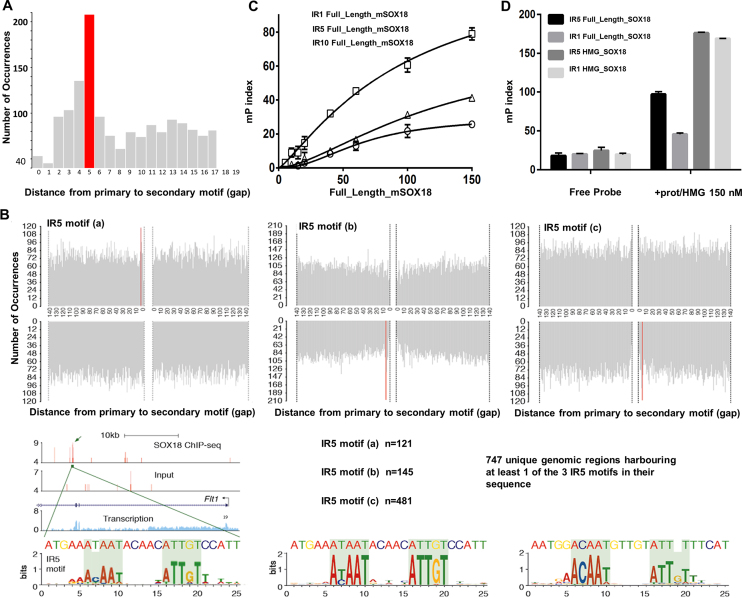
Identification of a consensus sequence for the homodimer of SOX18. (A) Spaced Motif Analysis Tool (SpaMo, MEME suite) analysis on SOX18 ChIP-seq data performed in HUVEC, showing the frequency of a secondary SOX18 motif in proximity of a primary SOX18 ChIP-seq peak at any given distance (1–140 bp). Enrichment for a 5-nucleotide spacer between a SOX inverted motif is shown in red (IR5, P = 0.005). (B) The four quadrants correspond to the strand orientation and upstream/downstream position relative to the ChIP-seq peak. An IR5 was identified for motif combination SOX18-SRY (IR5a), SRY-SRY (IR5b) and SOX18-SOX18 (IR5c). USCS browser track shows representative ChIP-seq peak in the FLT1 gene containing a SOX18 IR5a motif. Position weight matrixes show the inferred motifs based on the peaks containing the IR5a/b/c motifs. (C) Fluorescence polarization analysis of full-length SOX18 binding to FITC-labelled oligonucleotides harboring palindromic SOX18 binding motif identified in (B), separated by a 1 (IR1), 5 (IR5) or 10 (IR10) nucleotide spacer. Higher mP index indicates that SOX18 binds more favorably to IR5. (D) Fluorescence polarization analysis of full-length SOX18 and SOX18 HMG box construct binding to FITC-labelled oligonucleotides harboring palindromic SOX18 binding motif identified in (B), separated by a 5 (IR5) or 1 (IR1) nucleotide spacer (Supplementary Figure S2). Only IR5 and not IR1 can accommodate the dimer of full-length SOX18, but both can bind as efficiently to the HMG box.